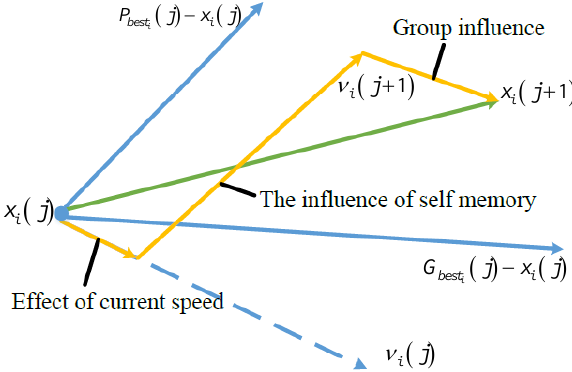
Figure 2. Searching criteria in the standard PSO algorithm.